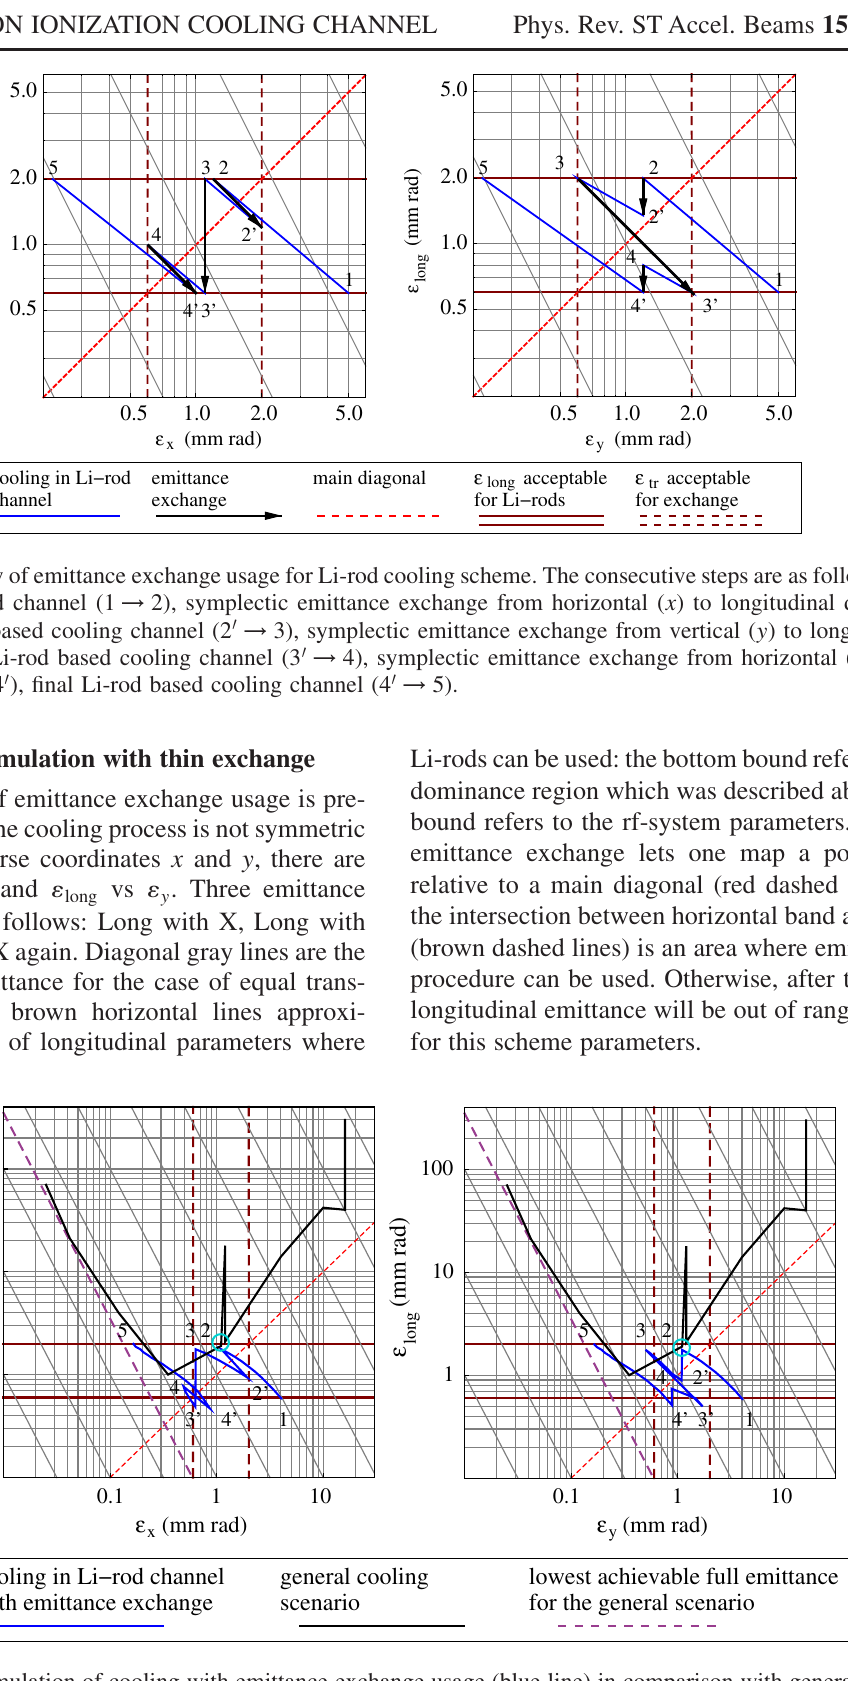
FIG. 10. Preliminary simulation of cooling with emittance exchange usage (blue line) in comparison with general cooling scenario for a muon collider (black line). The simulation is made in accordance with the conceptual view presented in Fig. 9, where steps of cooling are